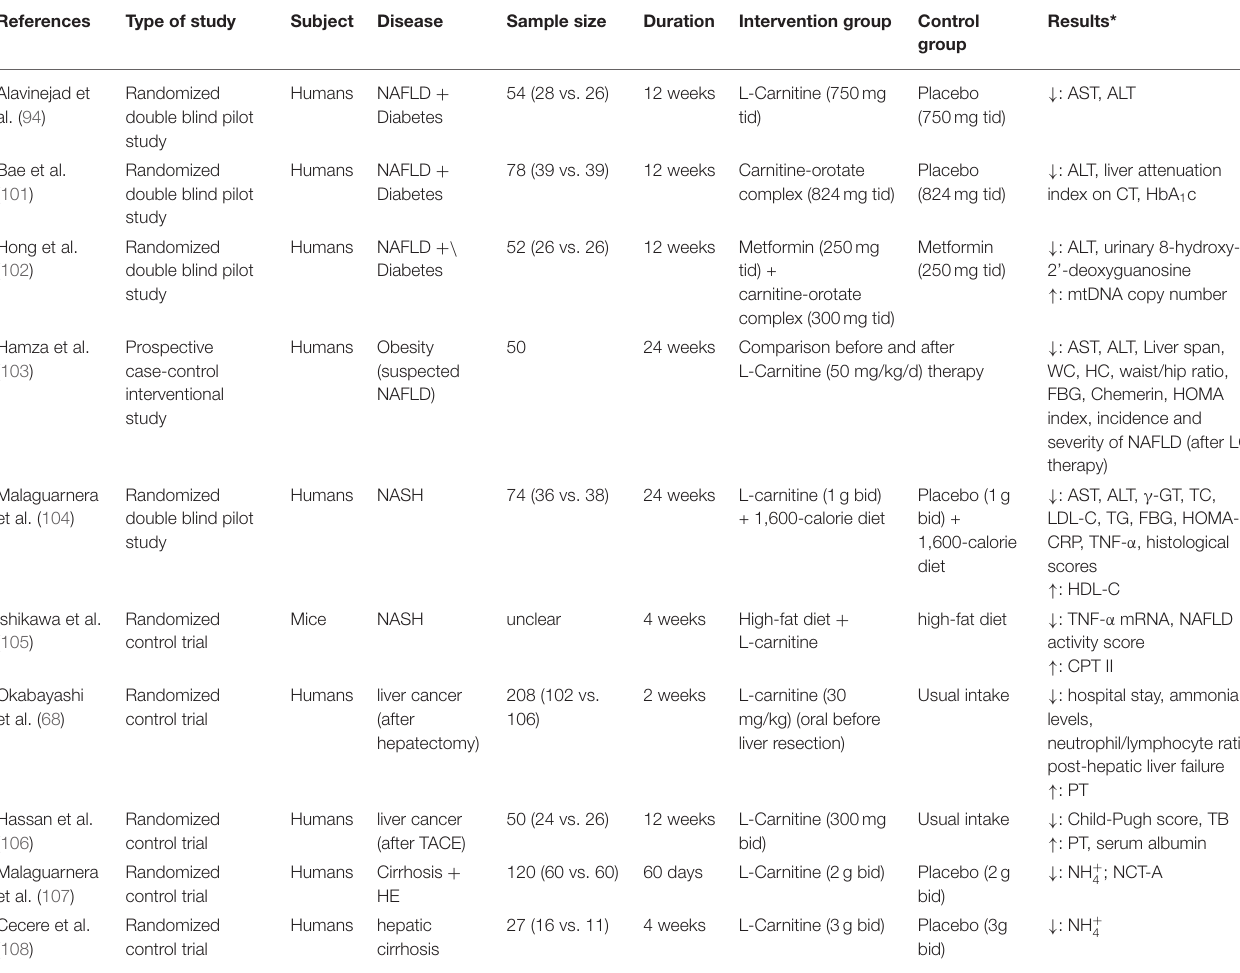
TABLE 2 | Studies reporting the effects of L-carnitine supplementation on NAFLD progression and related